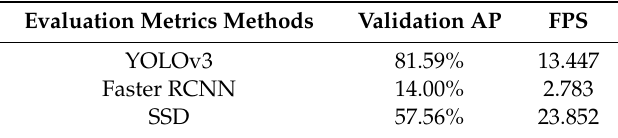
Table 1. Spot-checking comparison using di ff erent evaluation